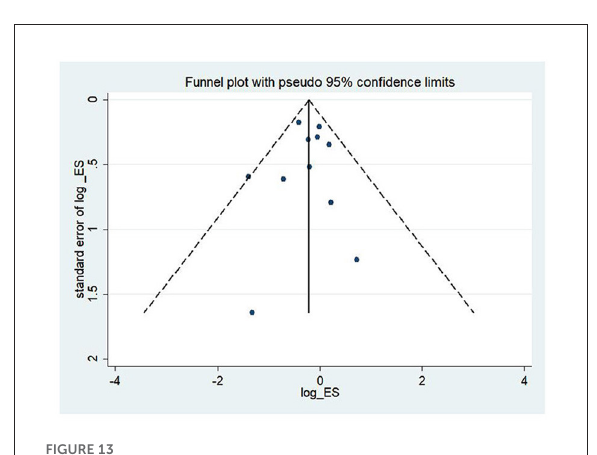
FIGURE13 Funnel plot of all-cause